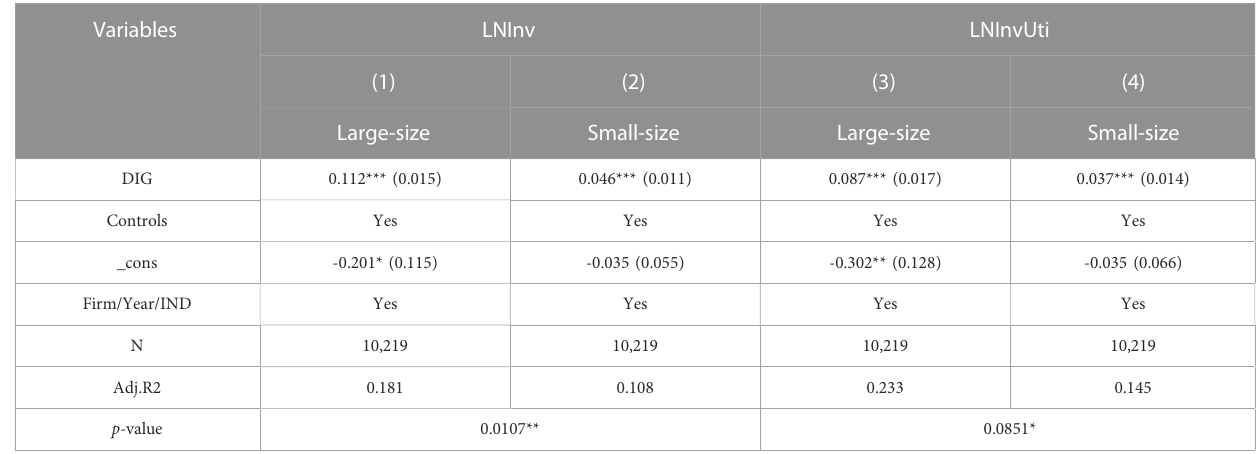
TABLE 12 Heterogeneity test based on fi rm